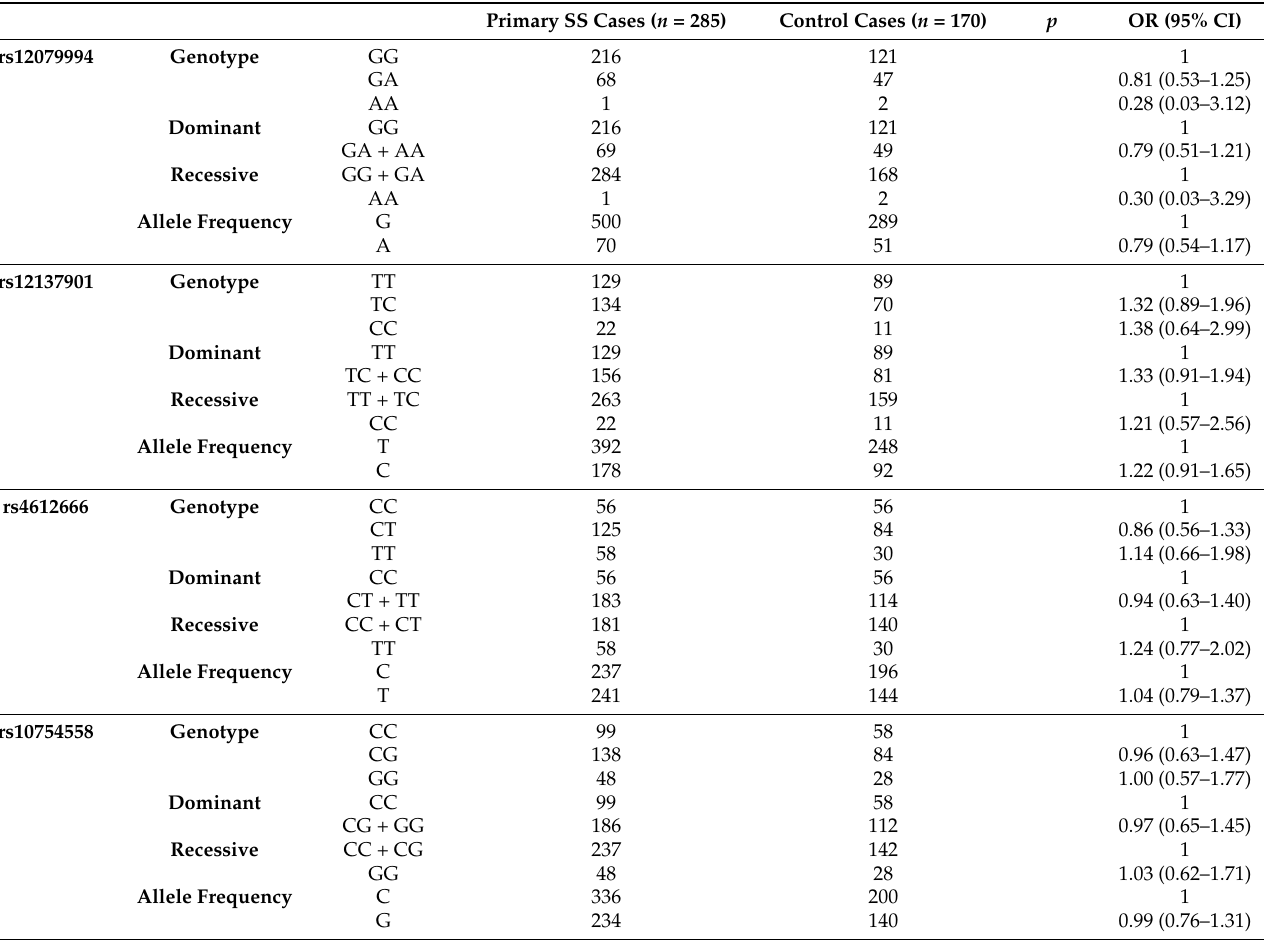
Table 2. Genotypes and allele frequency of NLRP3 gene in primary SS patients.